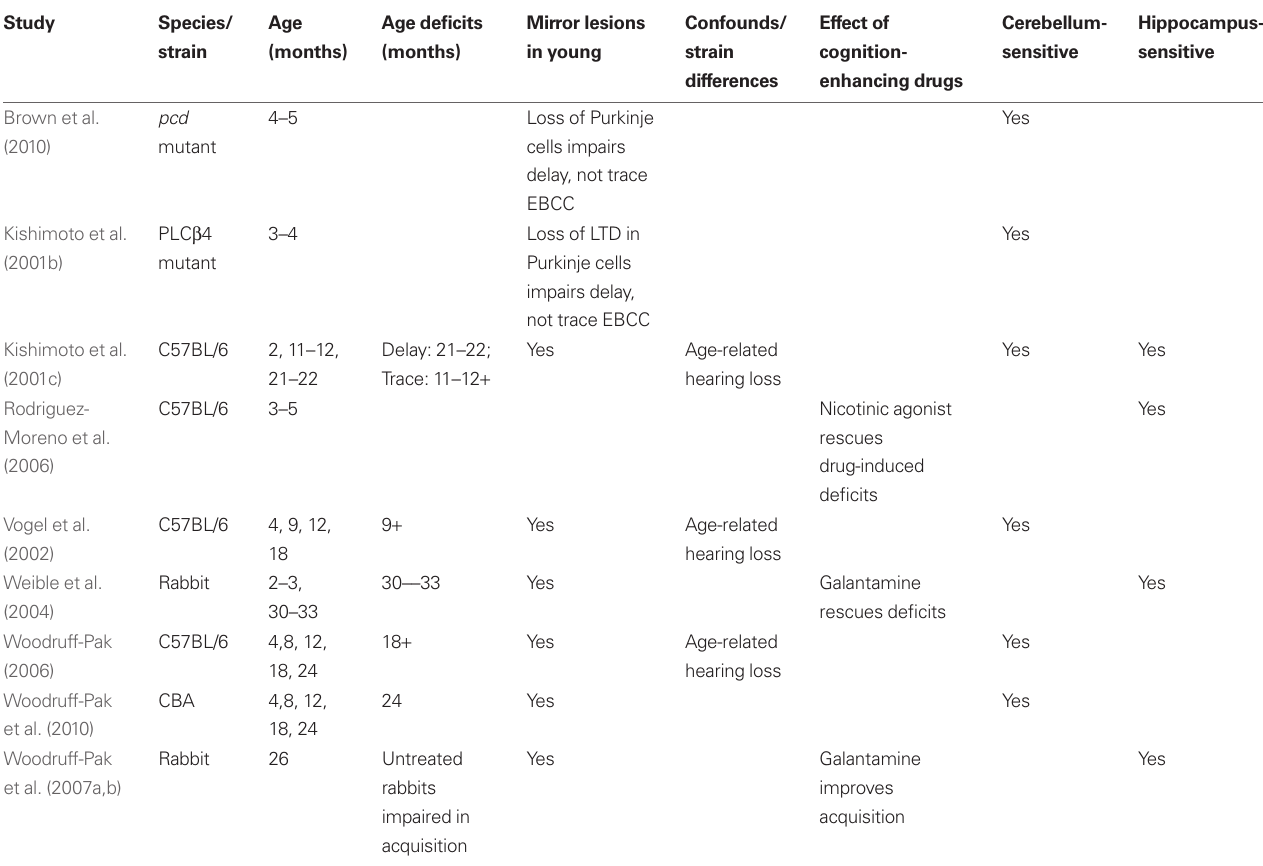
Table 4 | eyeblink classical conditioning: age sensitivity.